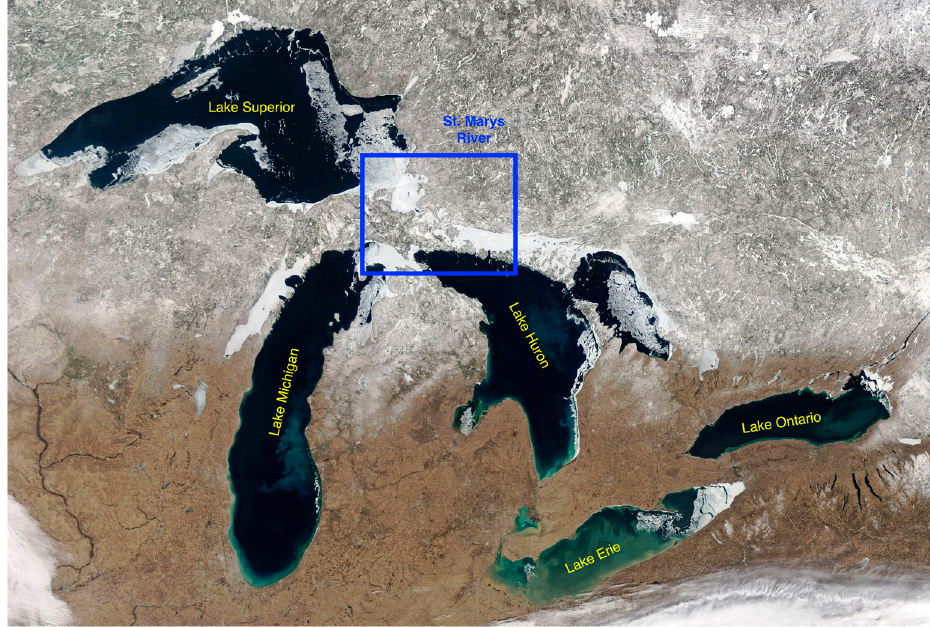
Figure 1. Satellite image of the Great Lakes taken on 25 March 25 2019 based on the Moderate Res- olution Imaging Spectroradiometer (MODIS) on NASA’s Terra satellite. Adapted from the NASA Earth Observatory website [6].